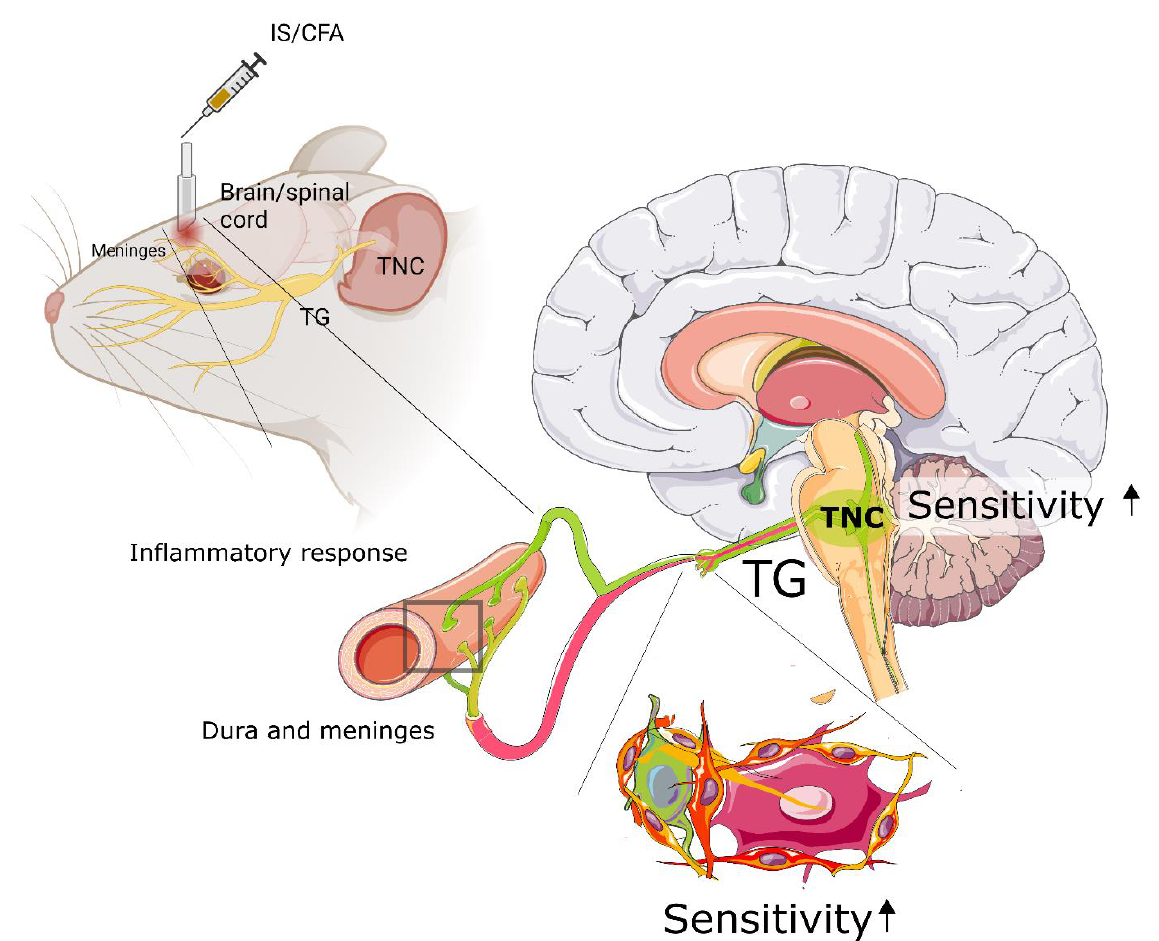
Figure 2. Sensitization in animal models. The chronification of migraines can to some extent be mimicked by the application of inflammatory substances such as Inflammatory Soup (IS) or Complete Freund’s Adjuvant (CFA) to the dura and meninges of rodents. Experimental data suggest that this activates satellite glial cells (indicated by a change in colour from orange to red) sensitizes (black arrow) the trigeminal ganglion (TG), and the trigeminal nucleus caudalis (TNC).